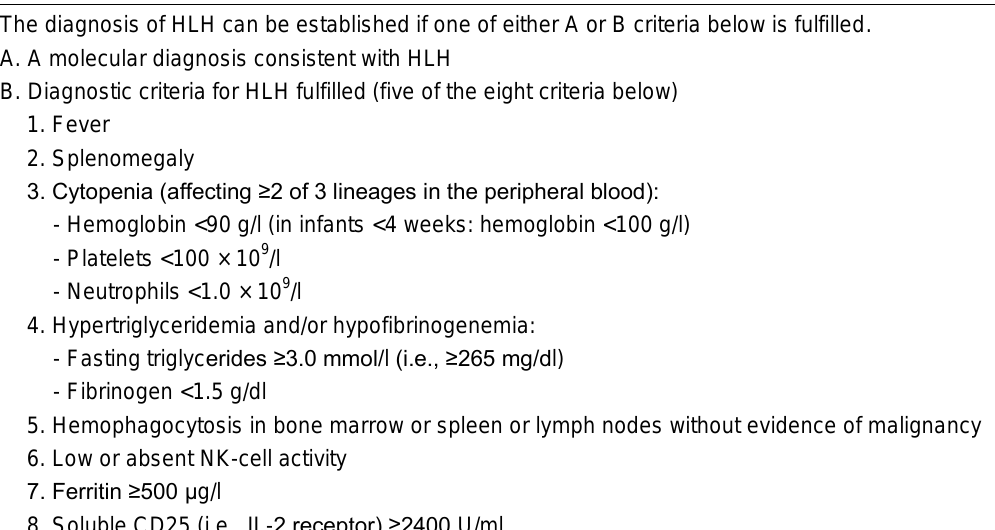
Diagnostic Criteria for